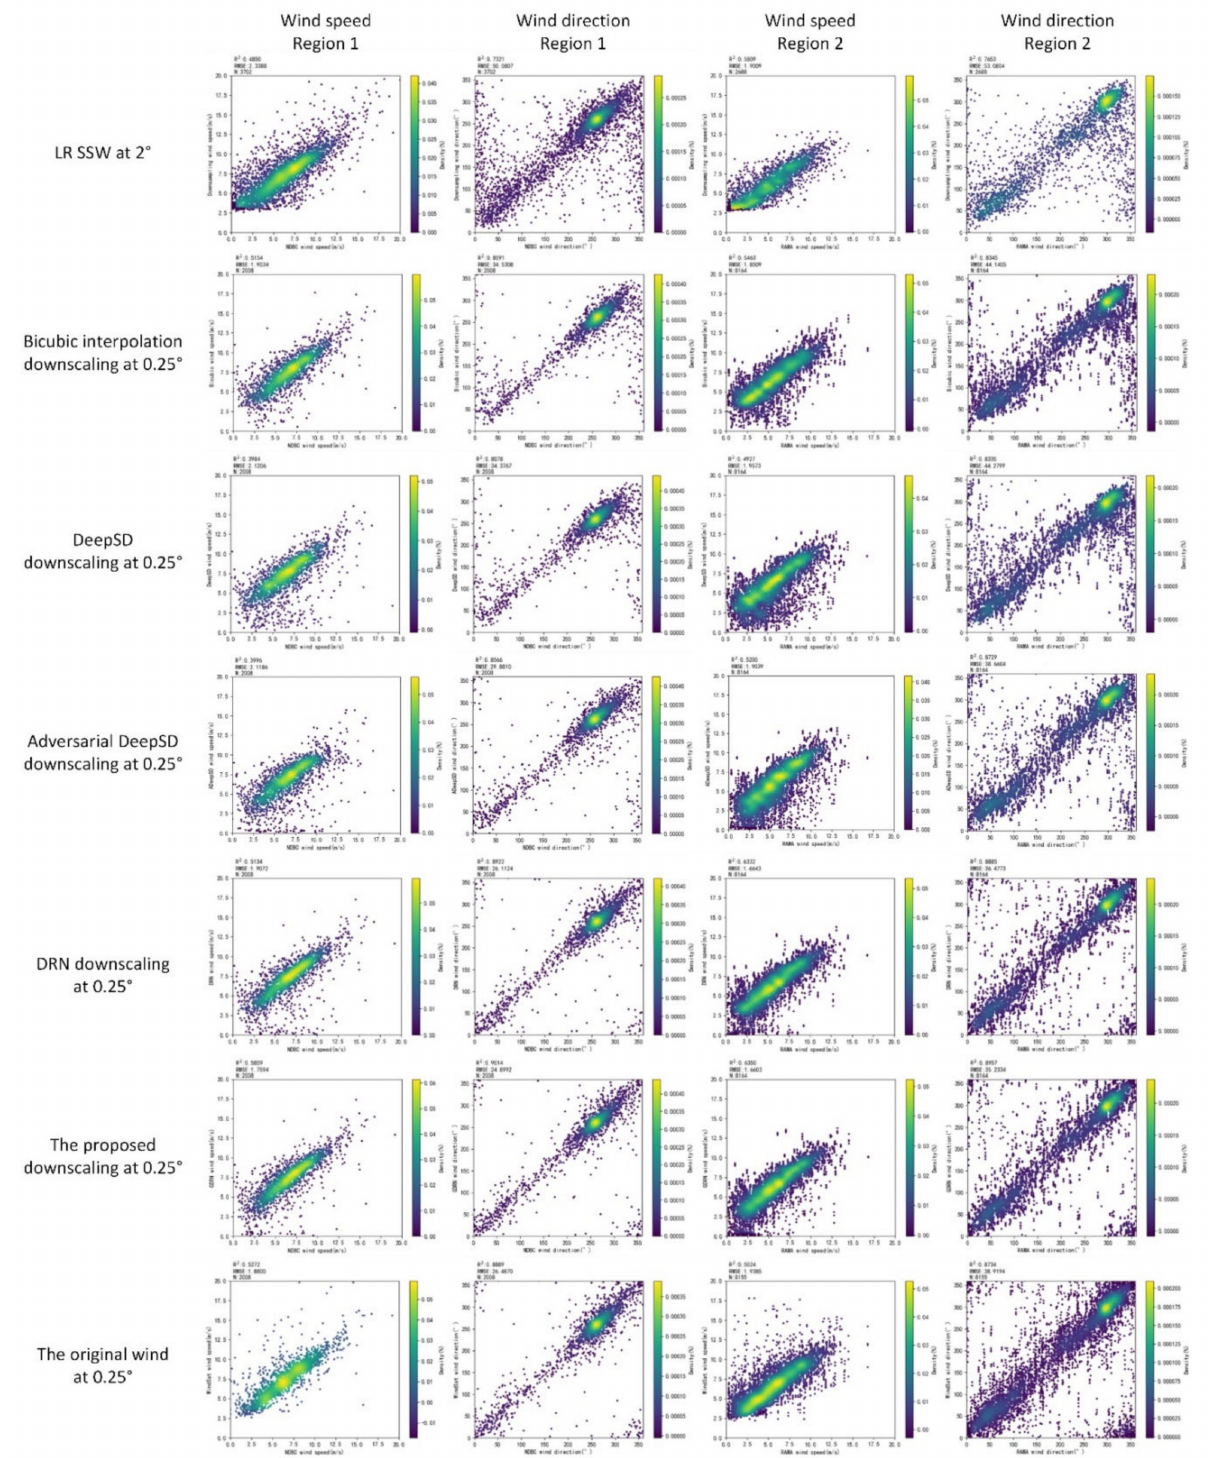
Figure 6. The accuracy validation results of sea surface wind with in situ buoy measurements in scatter plots with RMSE and R 2 for both the LR input at 2 ◦ and the downscaling reconstructed HR results at 0.25 ◦ on the test dataset. From left to right in each row, sub-images are for the wind speed and the wind direction in Region 1 and Region 2, as shown in Figure 1, respectively. From top to bottom, sub-images correspond to the validation results for the LR SSW at 2 ◦ , the bicubic interpolation downscaling, the DeepSD downscaling, the adversarial DeepSD downscaling, the DRN downscaling, the proposed method in this paper, and the original wind vector at 0.25 ◦